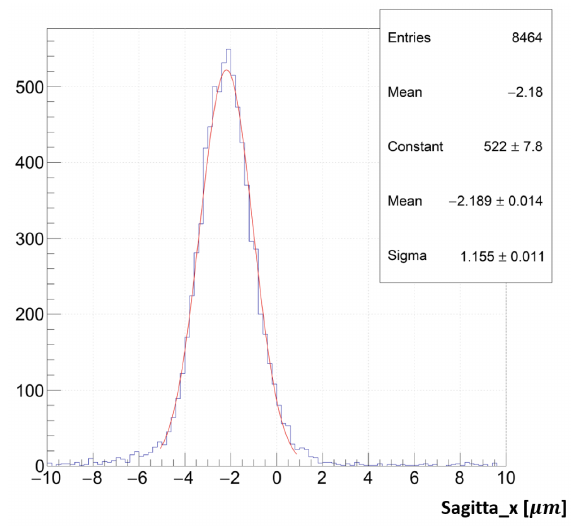
Figure 4. First measurement of 10 GeV / c pion momentum with a compact emulsion spectrometer: the sagitta is shown with its sign.